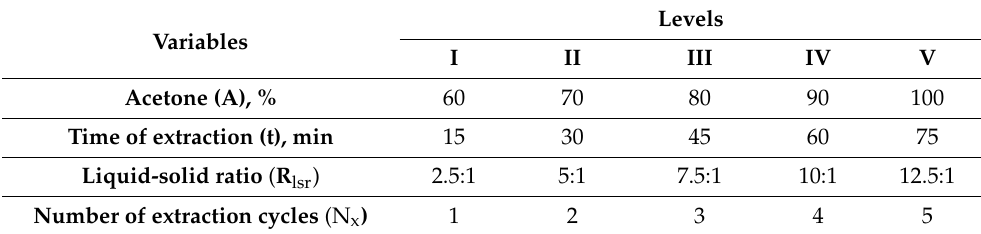
Table 1. Independent variables and their